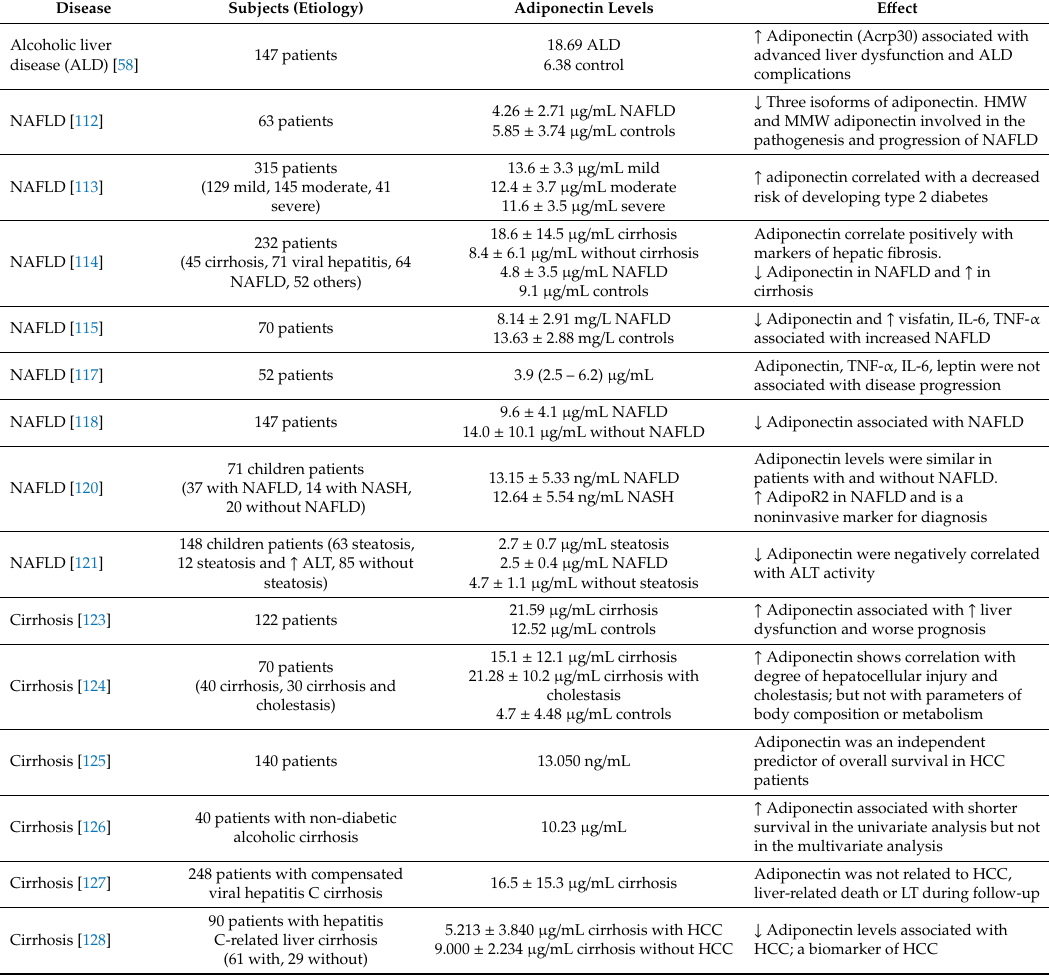
Table 3. Association between adiponectin levels and pathological characteristics in di ff erent liver disease.